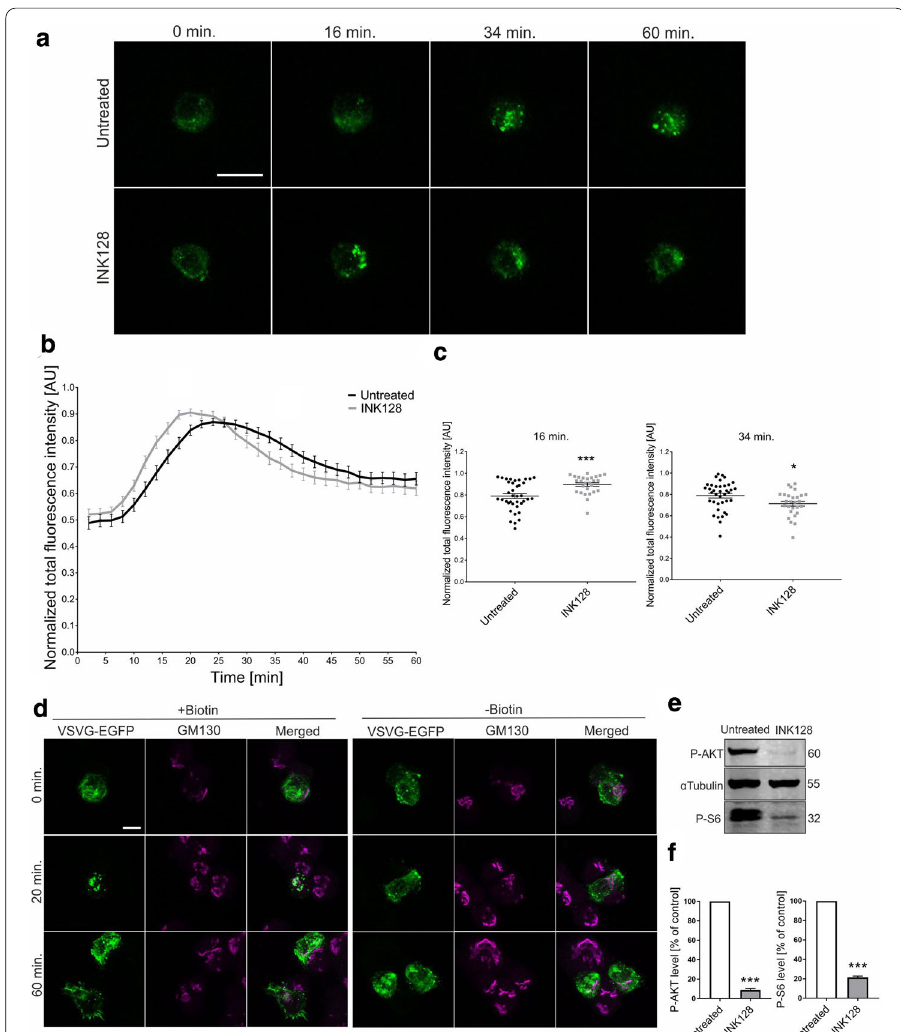
Fig. 2 Inhibition of mTOR affects ER-to-GA VSVg trafficking in PC12 cells. a Representative time-lapse confocal images of living PC12 cells that were transfected with Str-li_VSVGwt-SBP-EGFP and treated with INK128 (300 nM, 30 min) or untreated (control). Trafficking of VSVg-EGFP was visualized using the RUSH assay for 60 min after the addition of biotin (time 0). Scale bar 20 µm. b Quantitative analysis of the experiments = performed as in ( a ). The graph depicts VSVg-EGFP fluorescence intensity in the Golgi apparatus region at each time point, normalized to the maximum value. The data are expressed as the mean for all of the analyzed cells. Error bars indicate SEM. N 4 independent experiments. Number of cells per variant ( n ): = Untreated (38), INK128 (27). c Comparison of VSVg-EGFP fluorescence intensity in the Golgi apparatus region at 16 min (left panel) and 34 min (right panel). The data are expressed as the mean for all of the analyzed cells. Error bars indicate SEM. * p < 0.05, *** p < 0.001 (Mann–Whitney test). The number of independent experiments and analyzed cells per variant are the same as in ( b ). d Representative confocal images of PC12 cells that were transfected with Str-li_VSVGwt-SBP-EGFP (green) and immunofluorescently stained for the cis -Golgi marker GM130 (magenta). Scale bar 5 µm. e Western blot analysis of phospho-AKT (P-AKT) and phospho-S6 = (P-S6) levels in protein lysates from control PC12 cells or cells after INK128 treatment (300 nM, 30 min). f Quantification of Western blot analysis of P-AKT and P-S6, normalized to tubulin, in protein lysates that were obtained from PC12 cells that were treated as in ( e ). *** p < 0.001 (one-sample t -test). N 3 independent =